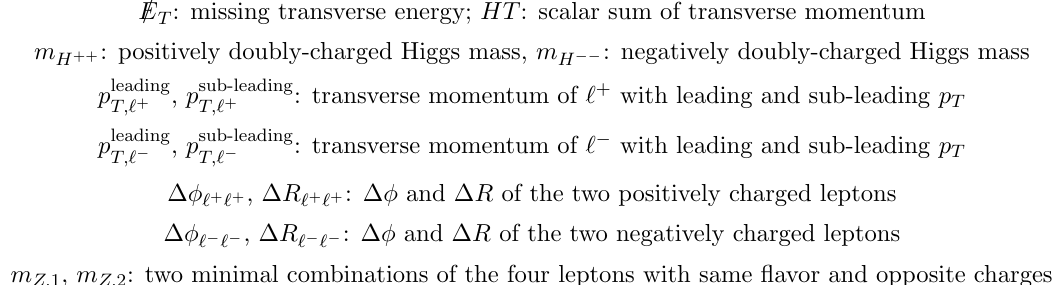
Table 2 . A list of BDT variables for the pp ! H (cid:6)(cid:6) H (cid:7)(cid:7) ! ‘ + ‘ + ‘ 0(cid:0) ‘ 0(cid:0) signal and its